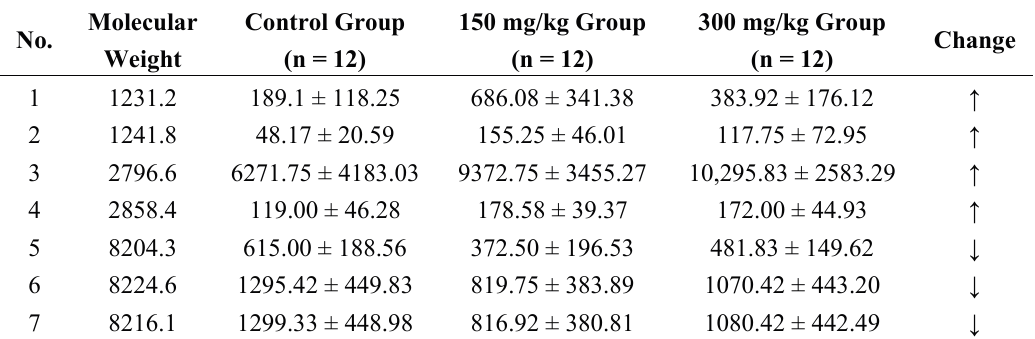
Table 3. Peak values of differentially-expressed peptides in benzene exposure groups. No.